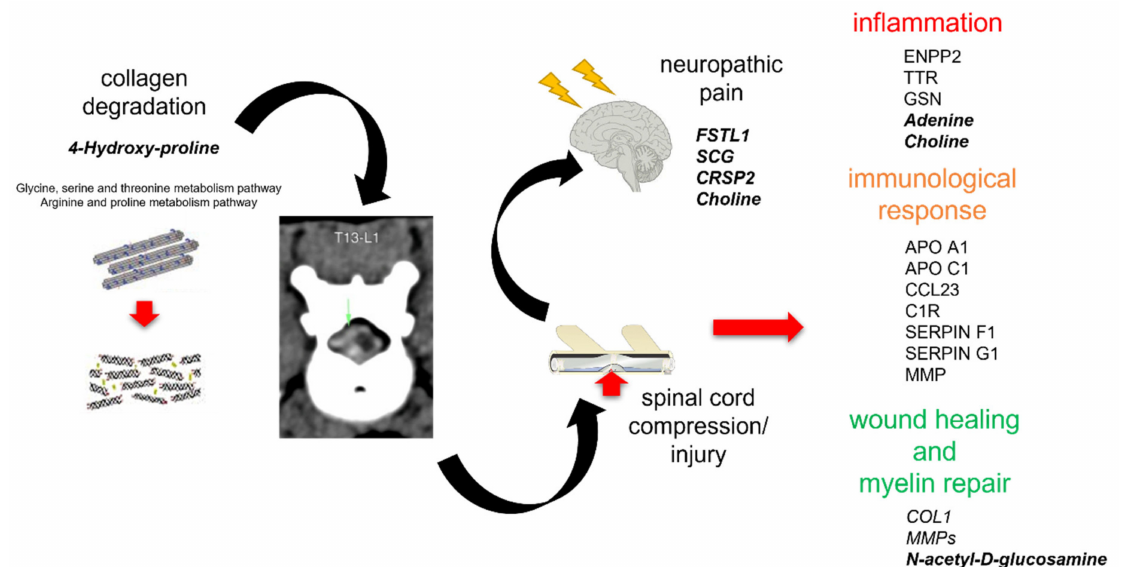
Figure 7. Complex processes occurring in cerebrospinal fluid of dogs with intervertebral disc herniation (IVDH) revealed by integrative omics approach pointing out the key molecules (in bold) proposed by our classification data-driven model. Related proteins: follistatin Like 1 (FSTL1), calcitonin receptor-stimulating peptide 2 precursor (CRSP2), secretogranin (SCG), nucleobindin 1 (NUCB1), Ectonucleotide Pyrophosphatase/Phosphodiesterase 2 (ENPP2), transthyretin (TTR), gelsolin (GSN), apolipoproteins (APO A1 and APO C1), C-C Motif Chemokine Ligand 23 (CCL23), Complement C1r (C1R), Serpins (SERPIN F1 and G1), matrix metalloproteinases (MMP) and collagen 1